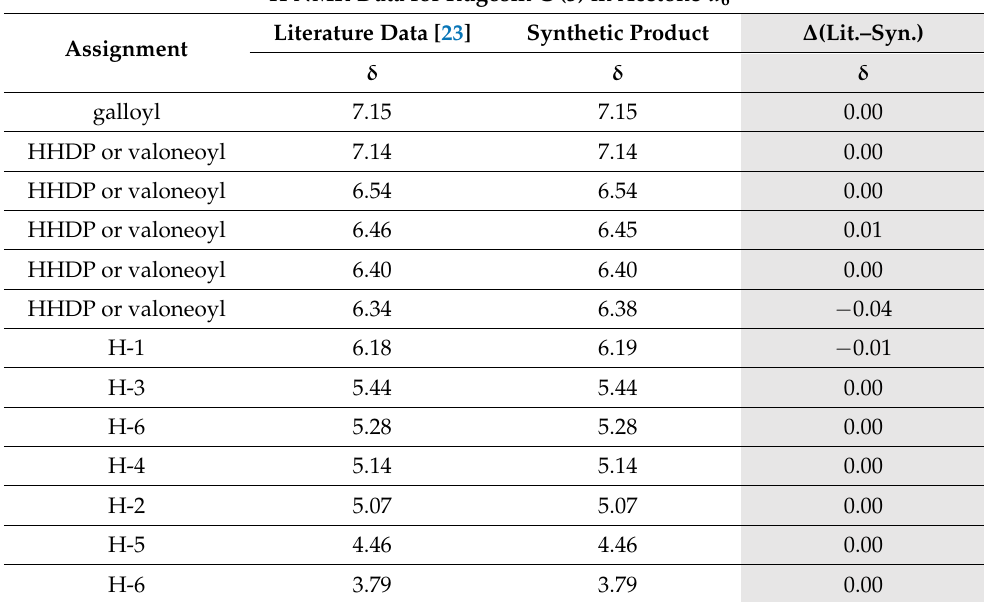
Table A4. Comparison of the 1 H NMR spectral data between the synthetic rugosin C ( 4 ) and the literature data of 4